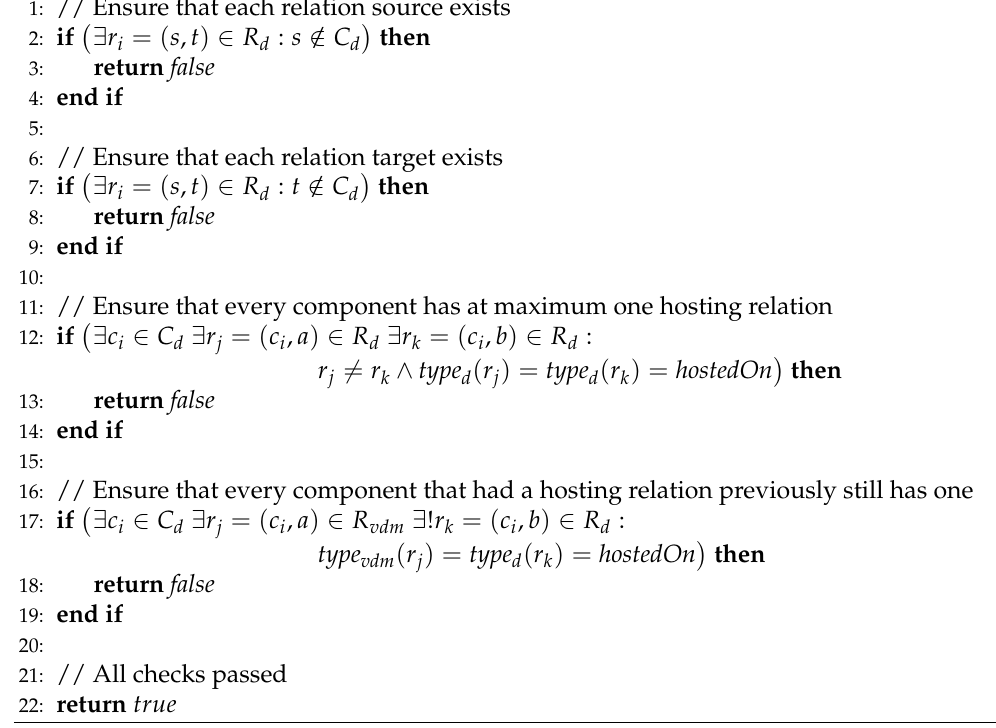
Algorithm 3 checkConsistency( d ∈ D vdm , vdm ∈ VDM ): b ∈ { true , false